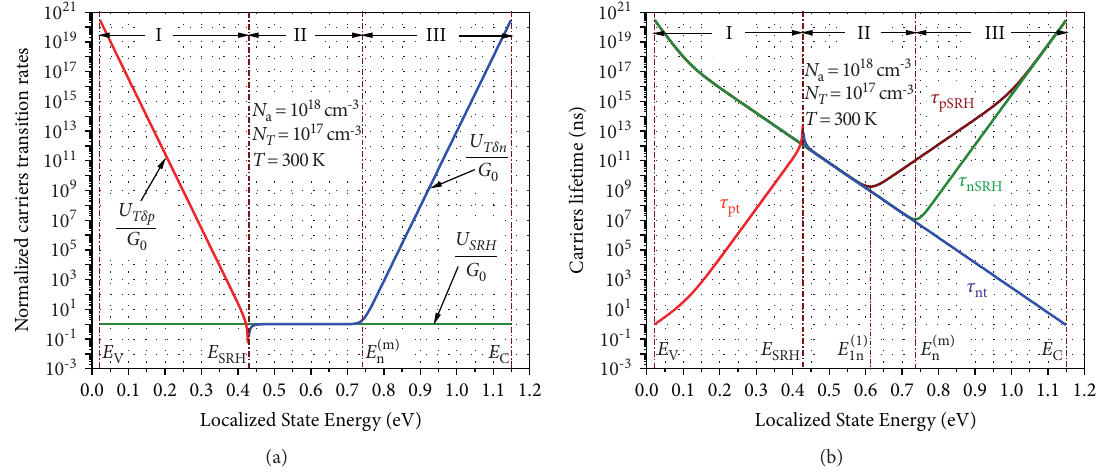
Figure 4: Room-temperature localized state energy dependence of (a) U curve) and (b) τ